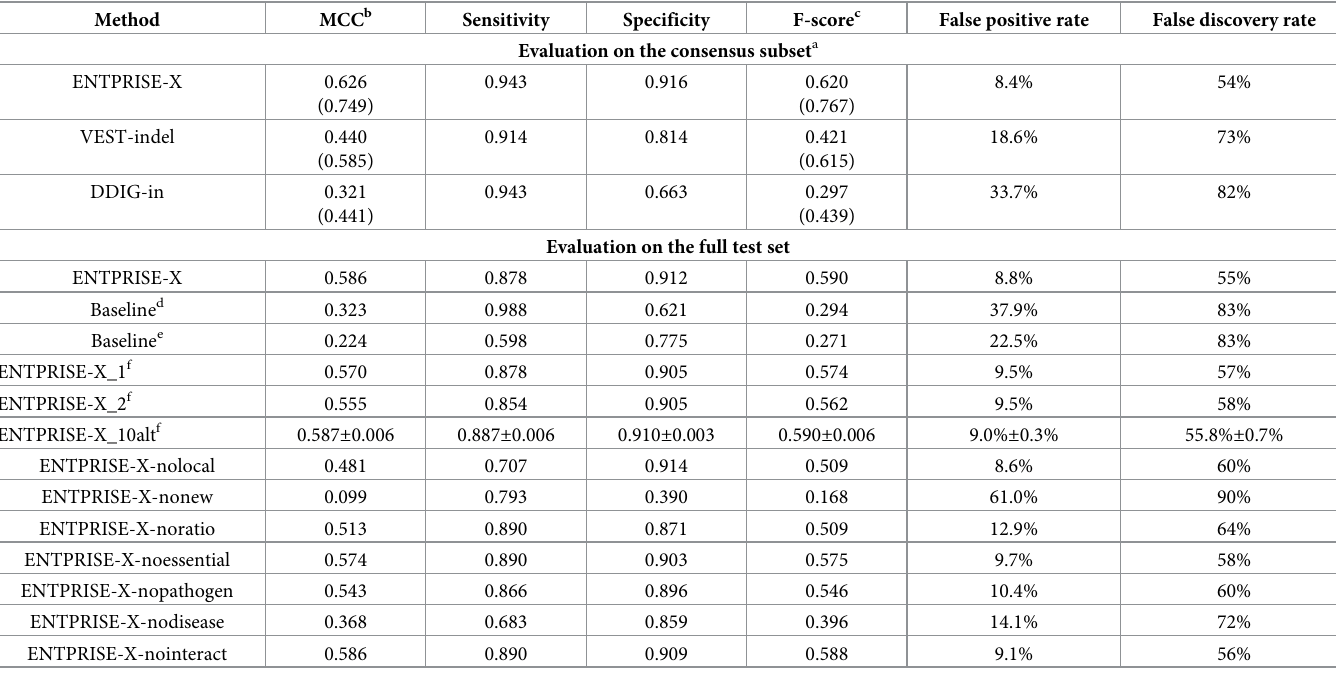
Table 2. Performance on the VEST-indel test set for frameshift